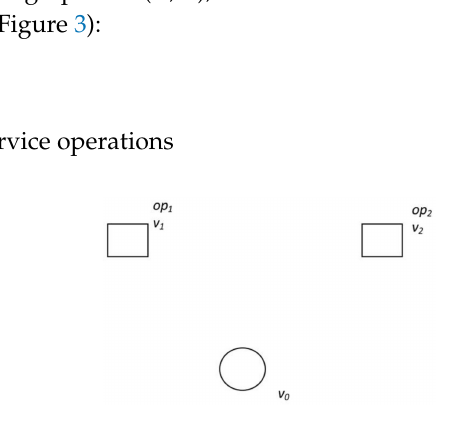
Figure 3. Example of nodes.